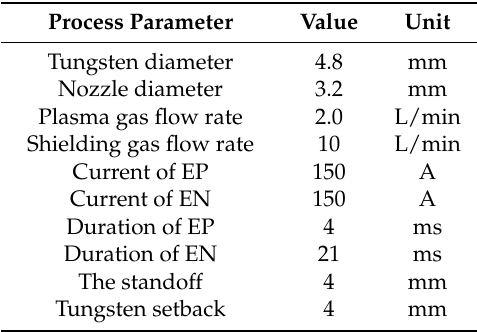
Figure 1. Measurement system of weld pool free surface in digging process of VPPA welding. Table 2. Parameters of VPPA welding in digging